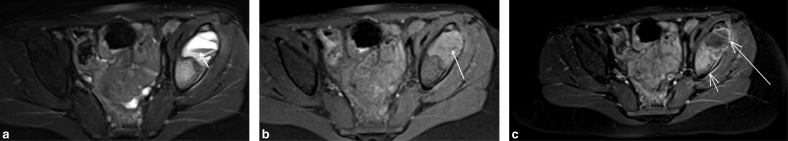
MRI of the pelvis demonstrating the fluid–fluid level. (a) T
2 weighted fat-saturated axial image demonstrates the fluid–fluid level (arrow) with low signal in its dependent portion, suggestive of blood products. (b) T
1 weighted fat-saturated axial image faintly demonstrates the fluid–fluid level (arrow). (c) Post-contrast T
1 weighted fat-saturated axial image demonstrates a linear enhancing septum within the osteolytic lesion (long arrow). Enhancement of the bone (short arrow) adjacent to the osteolytic lesion with fluid–fluid level is noteworthy.